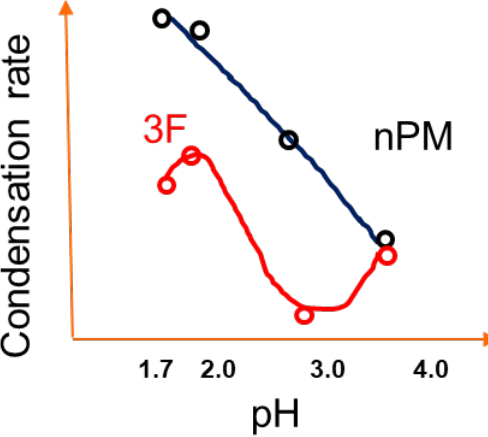
Figure 8. pH based condensation trends of nPM and 3F identified from Turbiscan. Due to electron-donating inductive e ff ects, the isoelectric point for nPM was expected to be at least 4.5 [22], and our data for nPM agree with acid-specific catalysis of condensation as the pH decreased from 4.0 to 1.7. For 3F, the presence of the highly electronegative fluorines lowers the isoelectric pH relative to the non-fluorinated nPM. TEOS has a point of zero charge near 2.2, and 3F appears to be between this and that of nPM, as the fluorines are three carbons removed from the silicon center, so the electron withdrawing inductive e ff ect is diminished. These trends are depicted in Figure